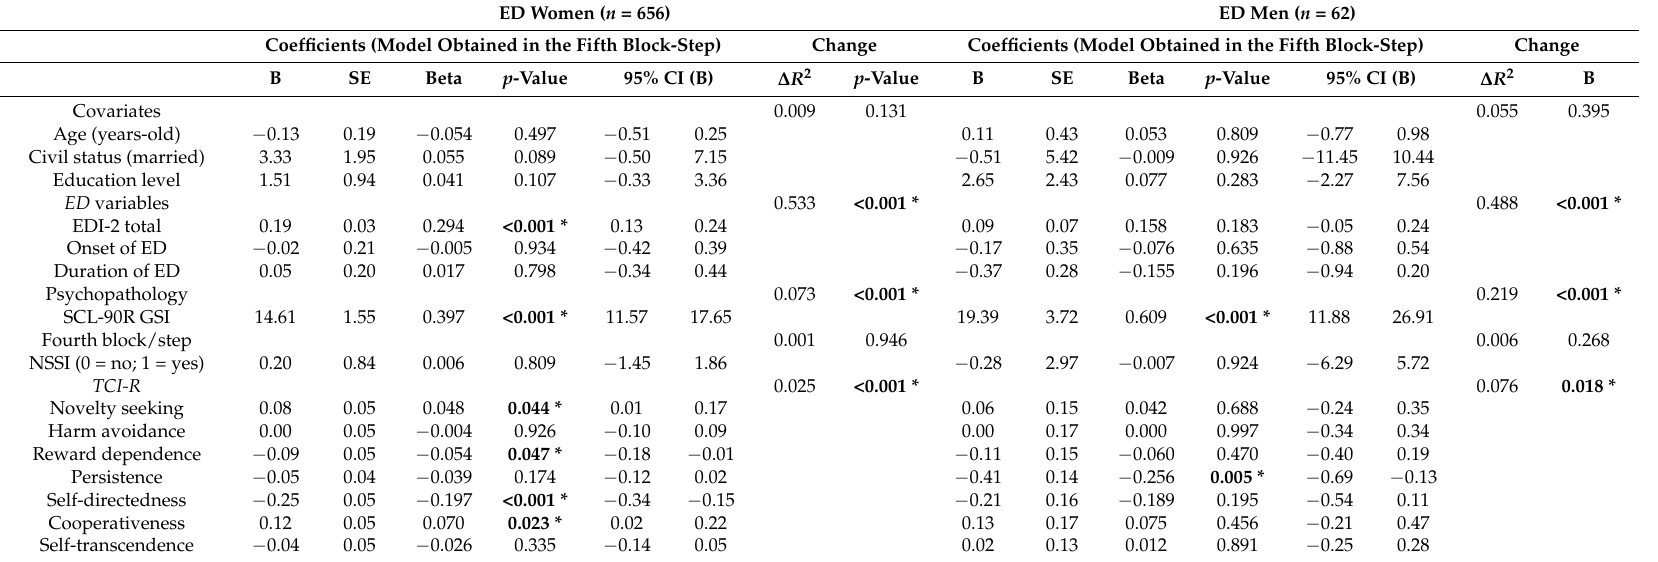
Table 4. Predictive model of the DERS total score: Multiple regression stratified by sex (ED subsample, n = 718). ED Women ( n = 656) ED Men ( n =